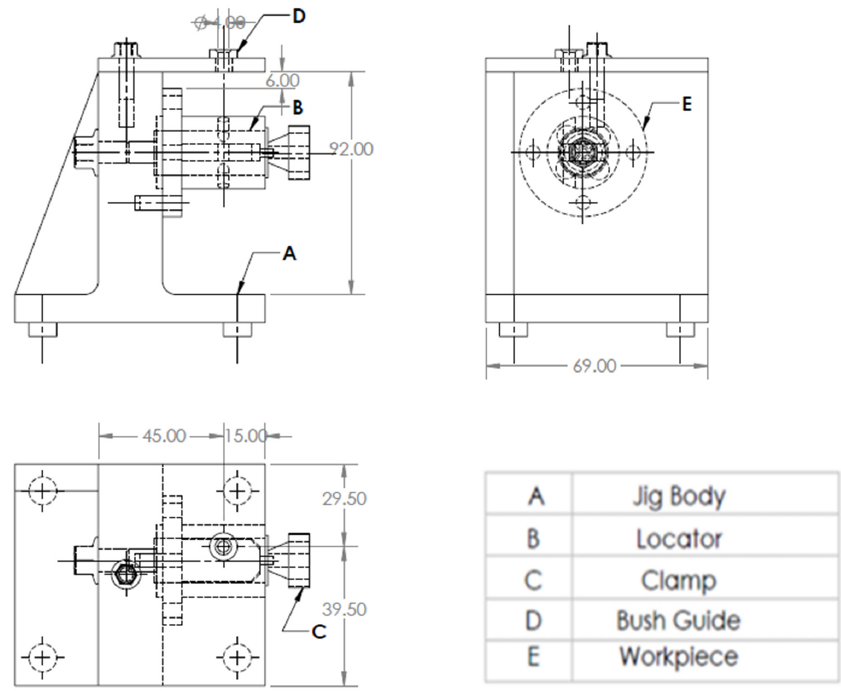
Figure 45. A drawing for the required jig design of the part.